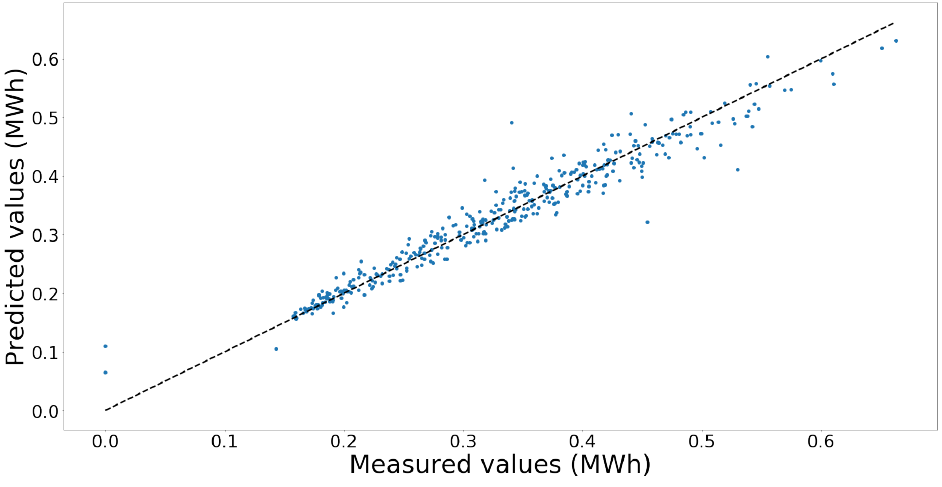
Figure 7. Predicted and actual values of load demand. Table 3. Evaluation of homomorphic encryption for regression problem (load forecasting).